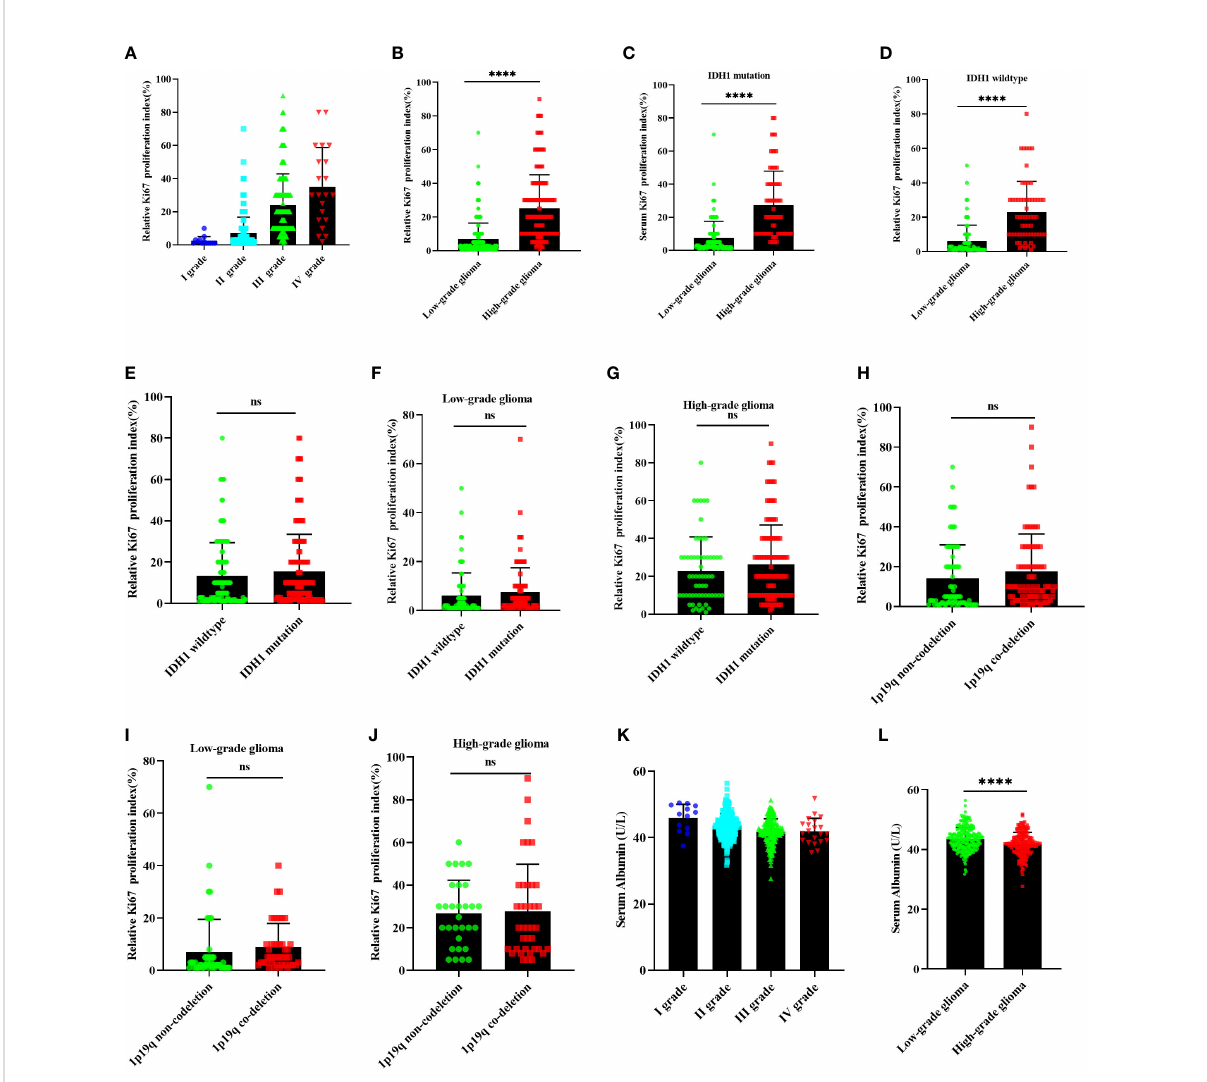
FIGURE 2 The relationship between Ki-67 expression and glioma, IDH1 mutation status, 1p19q co-deletion status. (A, B) the Ki-67 expression in glioma; (E – G) Ki-67 expression correlation with IDH1 mutation status in all glioma, LGG, and HGG; (H – J) Ki-67 expression correlation with 1p19q co-deletion status in all glioma, LGG, and HGG; (C, D) , Ki-67 expression correlation with glioma in IDH1 mutation group and IDH1 wild type group; (K, L) serum ALU correlation with glioma. LGG, lower-grade glioma; HGG, high-grade glioma; ALU, albumin. ns P > 0.05, **** P < 0.0001, mean ± standard deviation,